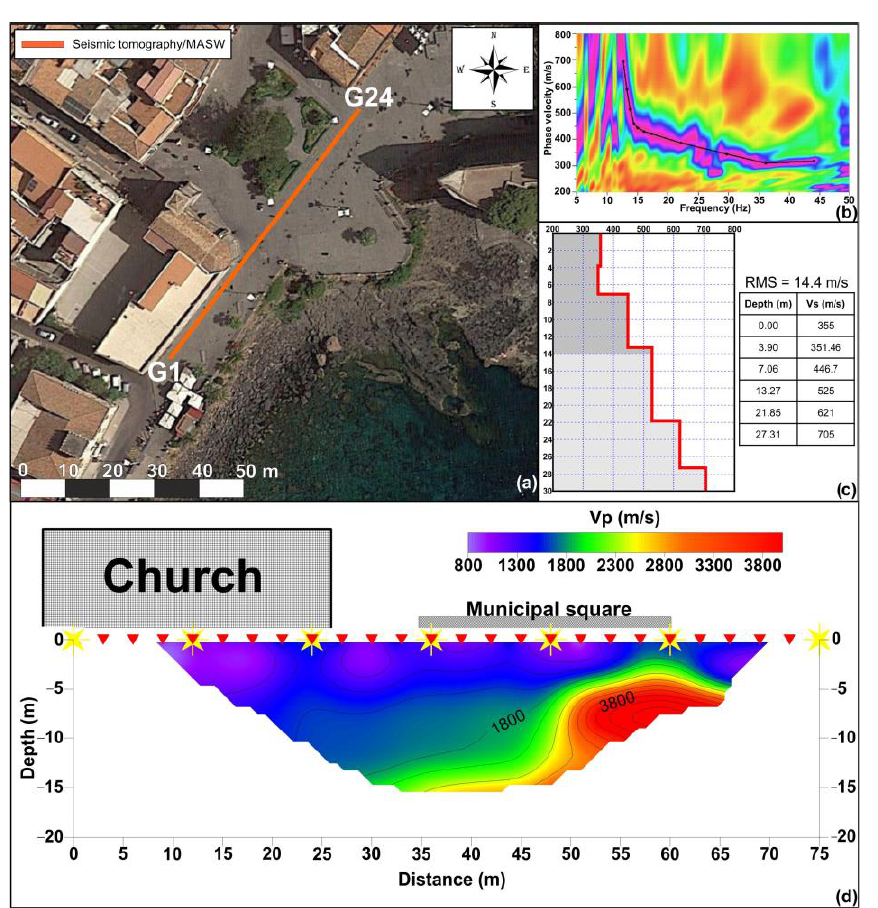
Figure 8. ( a ) Location of the seismic tomography and MASW surveys; ( b ) dispersion curve obtained from processing of MASW survey; ( c ) velocity model obtained from MASW surveys; ( d ) 2D seismic tomography section.